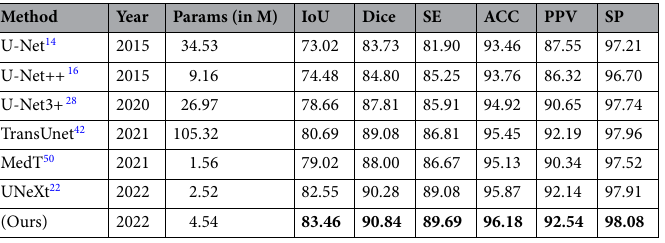
Table 2. Comparison results of the proposed method on ISIC 2018 dataset. Significant values are in [bold].